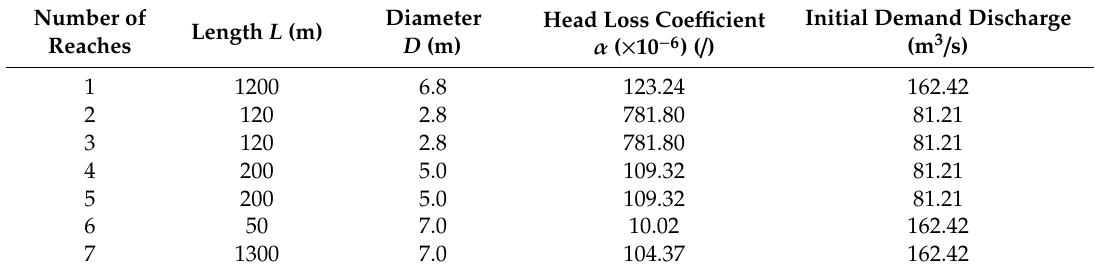
Table 1. Parameters of water conveyance system.